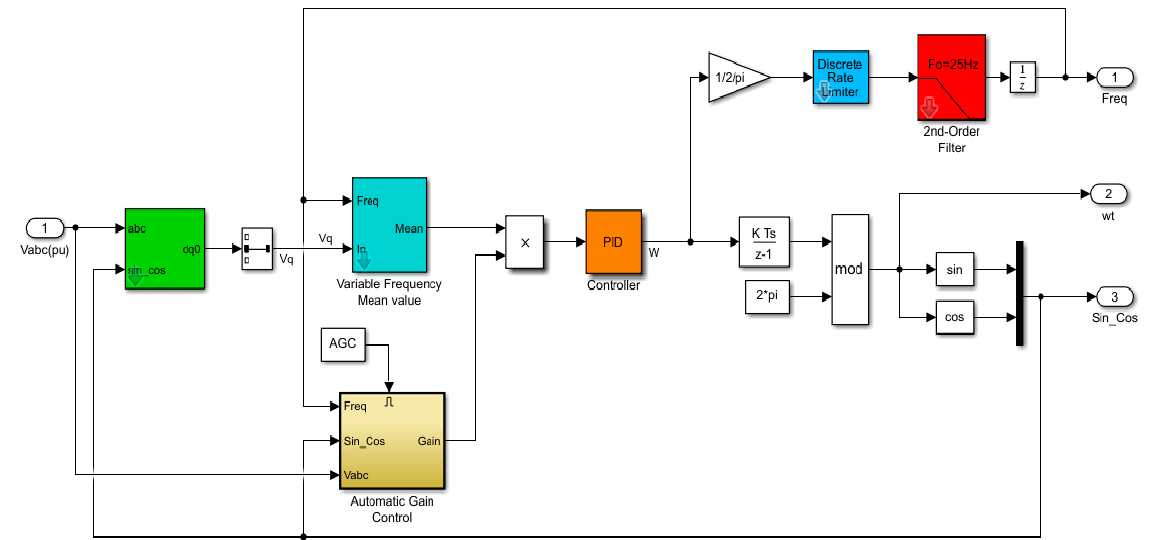
Figure 9. A three-phase PLL’s Simulink